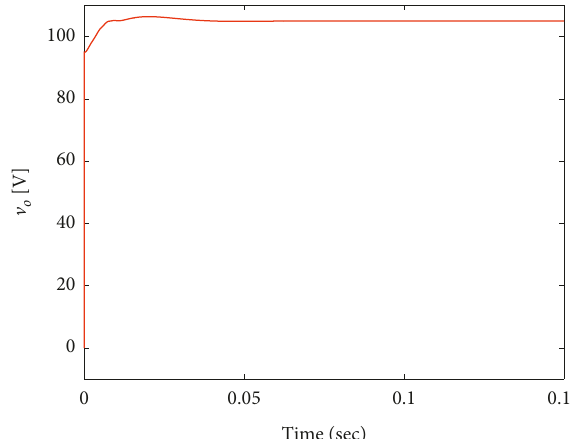
Figure 9: Transient response of output voltage in CV mode.